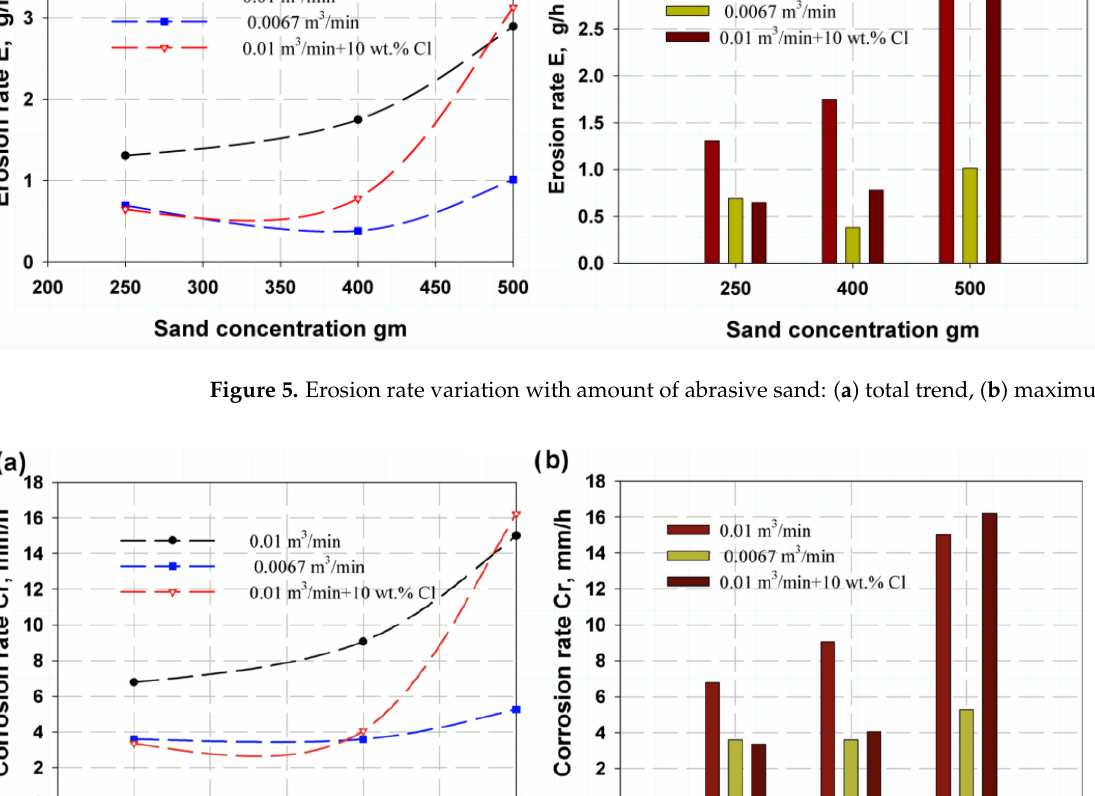
Figure 7. Erosion weight loss variation with time of impact ( a ) total trend, ( b ) maximum value . Figure 8. Failure mode at 2 h for ( a ) 250 g, ( b ) 400 g and ( c ) 500 g of sand at ( 1 ) 0.01 m 3 /min, ( 2 ) 0.0067 m 3 /min and ( 3 ) 0.01 m 3 /min +10 wt.% Cl.